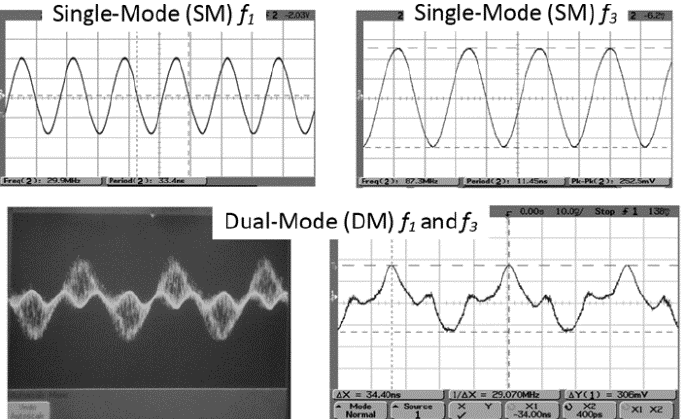
Figure 19. ( a ) SEM photo of device and the vibrating mode; ( b ) block diagram of Q-UCRB sensor. Reproduced with permission from [114]. Copyright © 2011, IEEE.